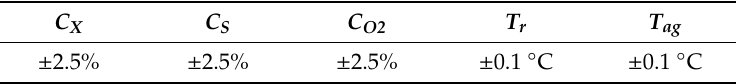
Table 3. Noise for the di ff erent measuring sensors.